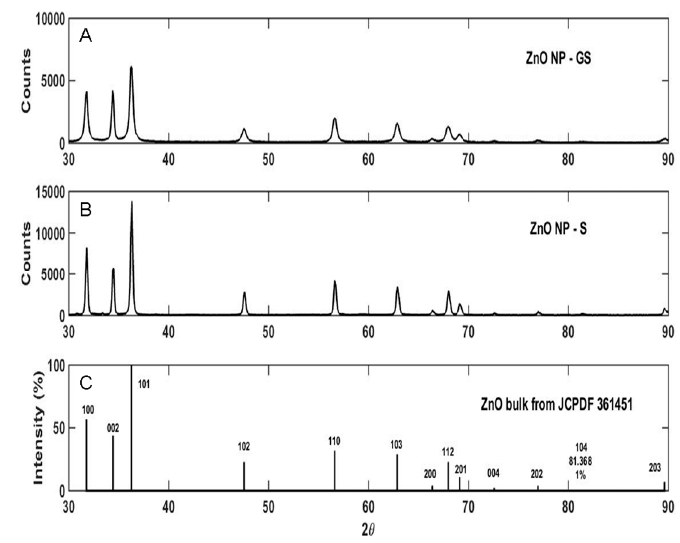
Figure 4. X-ray diffraction (XRD) pattern showing wurtzite crystalline structure of ( A ) ZnONP-GS and ( B ) ZnONP-S compared to ( C ) ZnO Bulk (JCPDS-36-1451).